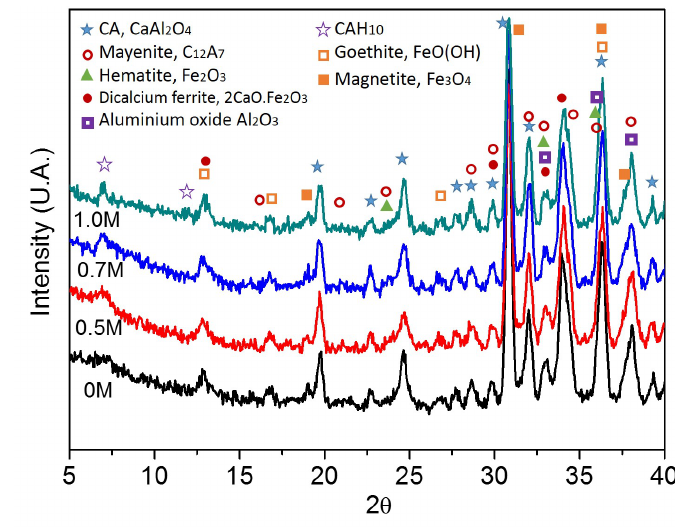
Figure 8. XRD Spectrum of dried aluminate after its interaction with aqueous chloride solutions (0 M, 0.5 M, 0.7 M, 1.0 M).